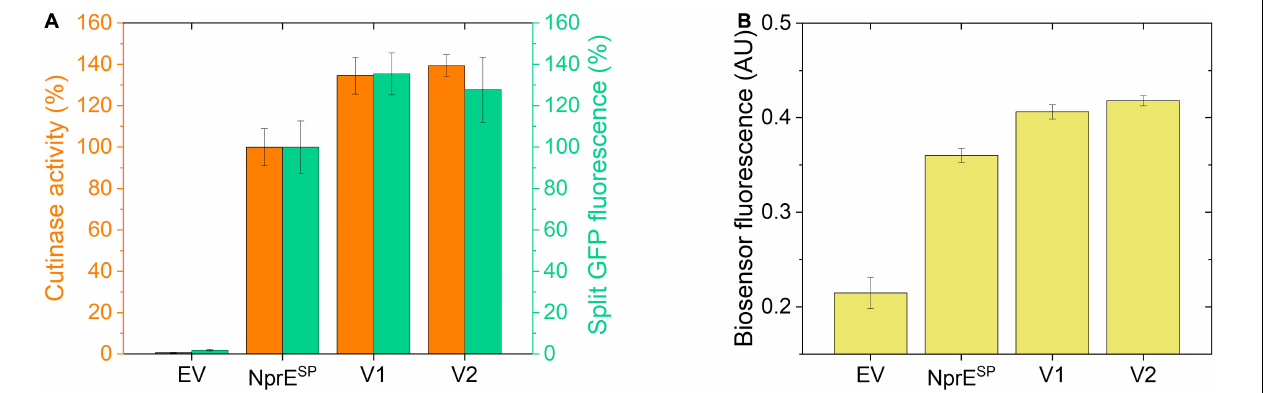
FIGURE 7 | Secretion performance of two variants obtained from the NprE SP -cutinase-GFP11 mutant library. Random mutagenesis of pPBEx2-NprE-cutinase-GFP11 and subsequent FACS analysis and screening of biosensor cells expressing the mutant library was performed as described for the Pel SP -cutinase-GFP11 mutant libraries. Plasmids were isolated from promising clones and then re-introduced in the C. glutamicum K9 biosensor strain. The recombinant strains were grown in CGXII medium containing 1% (v/v) glucose in a BioLector for 24 h at 30 ◦ C, 1,200 rpm and 85% relative humidity along with the control strains harboring pPBEx2 (EV) or pPBEx2-NprE-cutinase-GFP11 (NprE SP ). Four hours after inoculation, IPTG was added to the cultures to a final concentration of 250 µ M. (A) At the end of the cultivation (24 h) the amount and activity of the extracellular cutinase-GFP11 was determined by split GFP fluorescence (green bars) and cutinase activity measurements (orange bars), respectively. (B) The specific fluorescence of the corresponding biosensor cells at the end of the cultivation (24 h) is